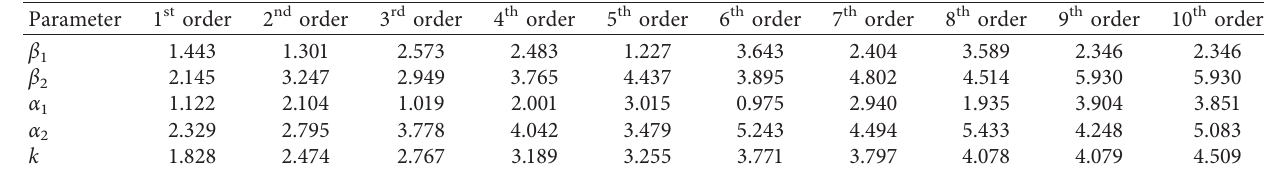
Table 4: The first 10 vibration parameters of the thin plate rock mass under free vibration (C-C-C-C).